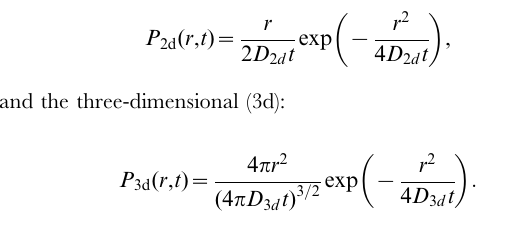
Figure S1 POPC angle distributions showing the orientation of the P-N vector and hydrocarbon chains with respect to the effective normal. Figure S2 Distributions of TG conformations in different regions of HDL. Distributions are given in terms of the angle between the hydrocarbon sn -1 and sn -3 chains, and the angle between the sn -1 and sn -2 chains. Figure S3 Conformations of cholesteryl ester and triglyceride in different parts of the droplet. Figure S4 Angle distributions describing cholesteryl ester conformations. Figure S5 Angle distributions characterizing conformations of triglyceride molecules. Figure S6 Displacement distributions for CE (Panel A) and POPC (Panel B) together with the fits of P 2d and P 3d . Found at: doi:10.1371/journal.pcbi.1000964.s006 (0.19 MB PDF) Table S1 Average percentages of different moieties of each lipid component interacting with apoA-I. Found at: doi:10.1371/journal.pcbi.1000964.s007 (0.01 MB PDF) Text S1 Description of additional data (for Figures S1, S2, S3, S4, S5, S6 and Table S1), details of coarse-grained model construction, and description of diffusion